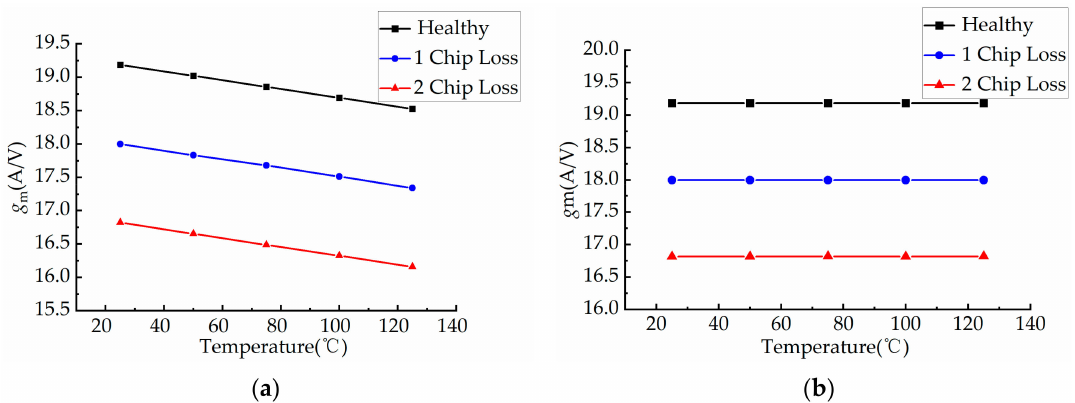
Figure 8. Transconductance of the IGBT module with chip failure: ( a ) before temperature calibration ( b ) after temperature